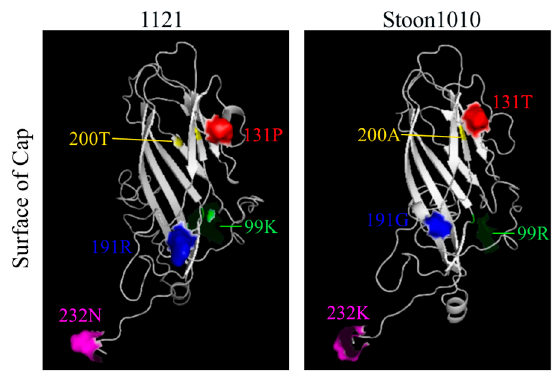
Figure 14. Location of strain-specific amino acids on the respective ribbon diagram of the PCV2 capsid protein of strains 1121 and Stoon1010. The 3D structures of the capsids were generated using I-TASSER server and displayed with PyMOL.